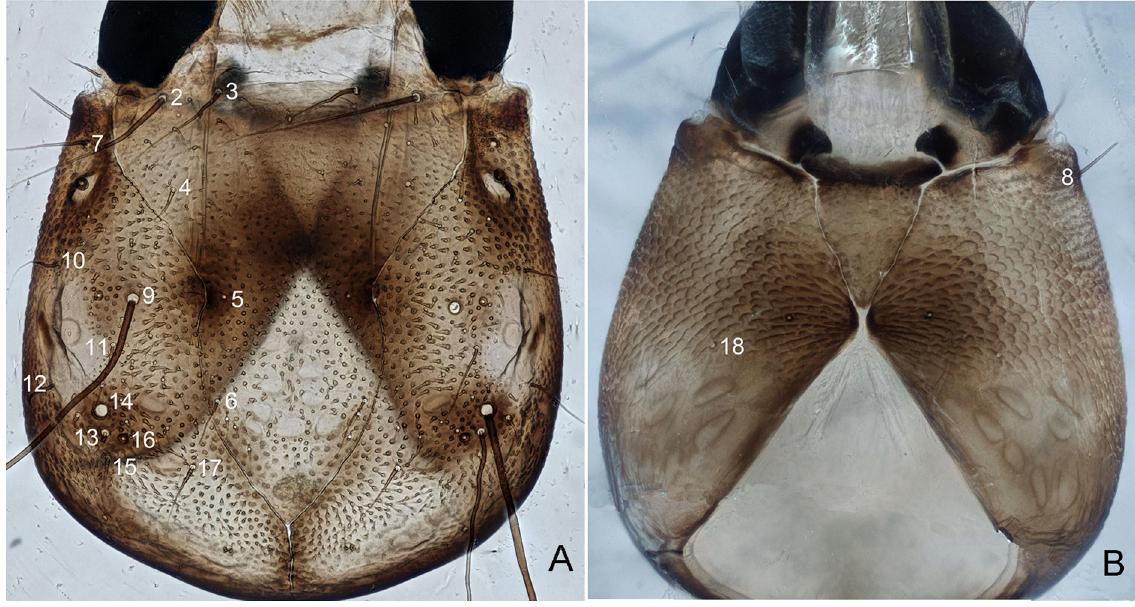
Fig. 8. Head setae of Apatidelia acuminata Leng & Yang, 1998, larva. A . Dorsal view. B . Ventral view. Scale bar = 0.5